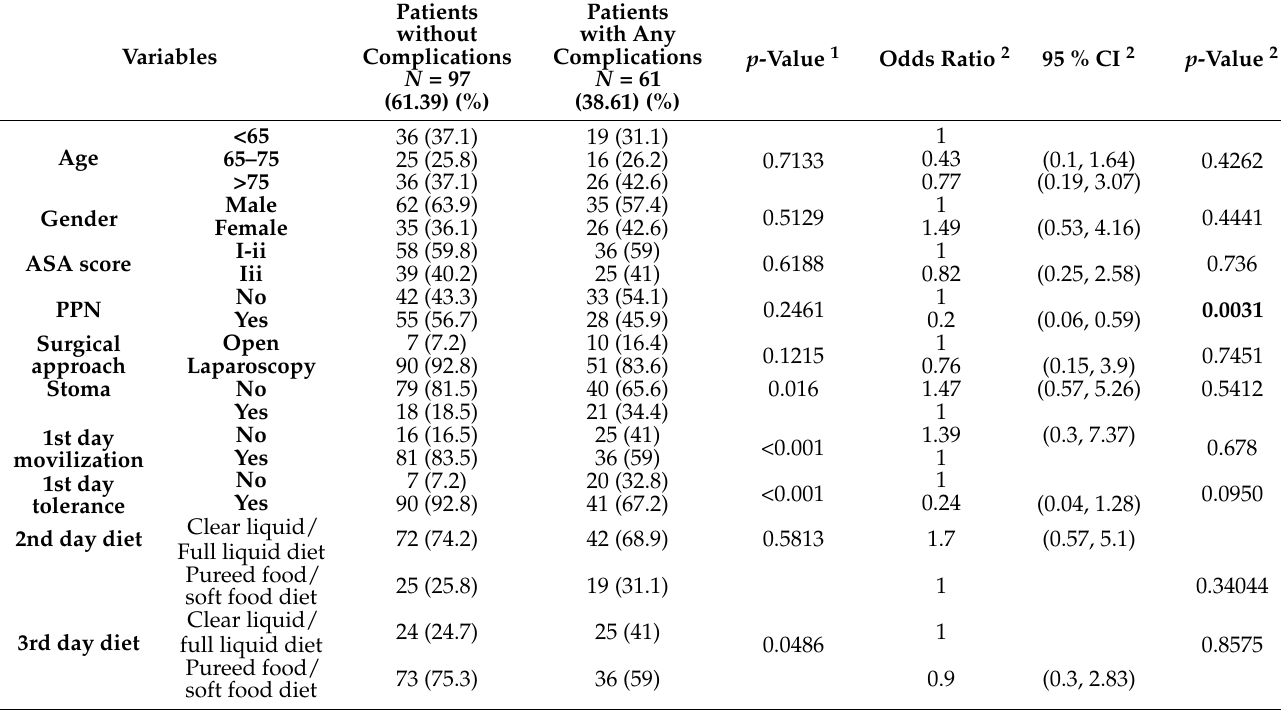
Table 4. Association of categorical variables related to the patient, the surgery, and the tumor with morbidity at univariate analysis ( χ 2 test) and evaluation of independent risk factors for morbidity by multivariate analysis (logistic regression) with a Wald test for global variable significance.